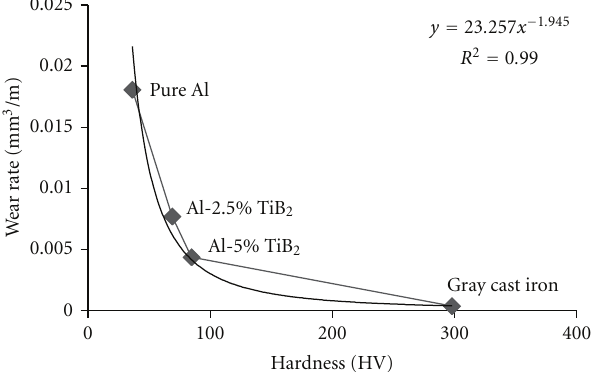
Figure 14: E ff ect of fracture strength on wear rates of